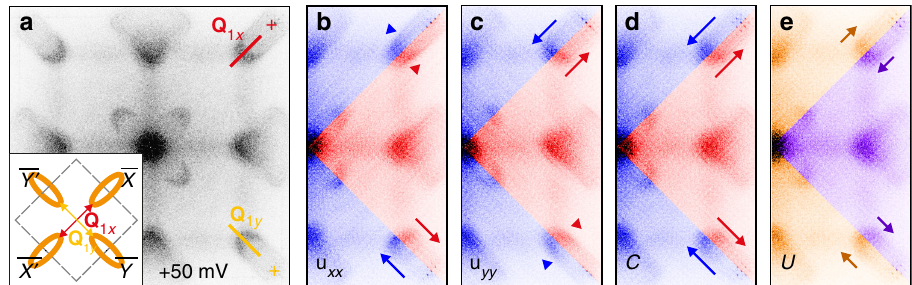
Fig. 3 Strain- fi ltered Fourier transforms of d I /d V . a The Fourier transform of d I /d V acquired in the 130 nm area shown in Fig. 2a; the indicated features Q 1 x and Q 1 y represent scattering across the center of the Brillouin zone between the inner portions of the pockets (inset) at X , X ′ , and Y , Y ′ respectively. b – e The Fourier transforms of masked d I /d V , with masks chosen to capture the maxima (blue in b – d , orange in e , and minima (red in b – d and purple in e ) of u xx , u yy , C , and U , respectively; the arrows are guides to the eye. In b – e , the blue (orange) and red (purple) subsets correspond to masks coincident with the blue (orange) and red (purple) areas of Fig. 2c, f, g, h, respectively. For details of the masking procedure, see Supplementary Note II